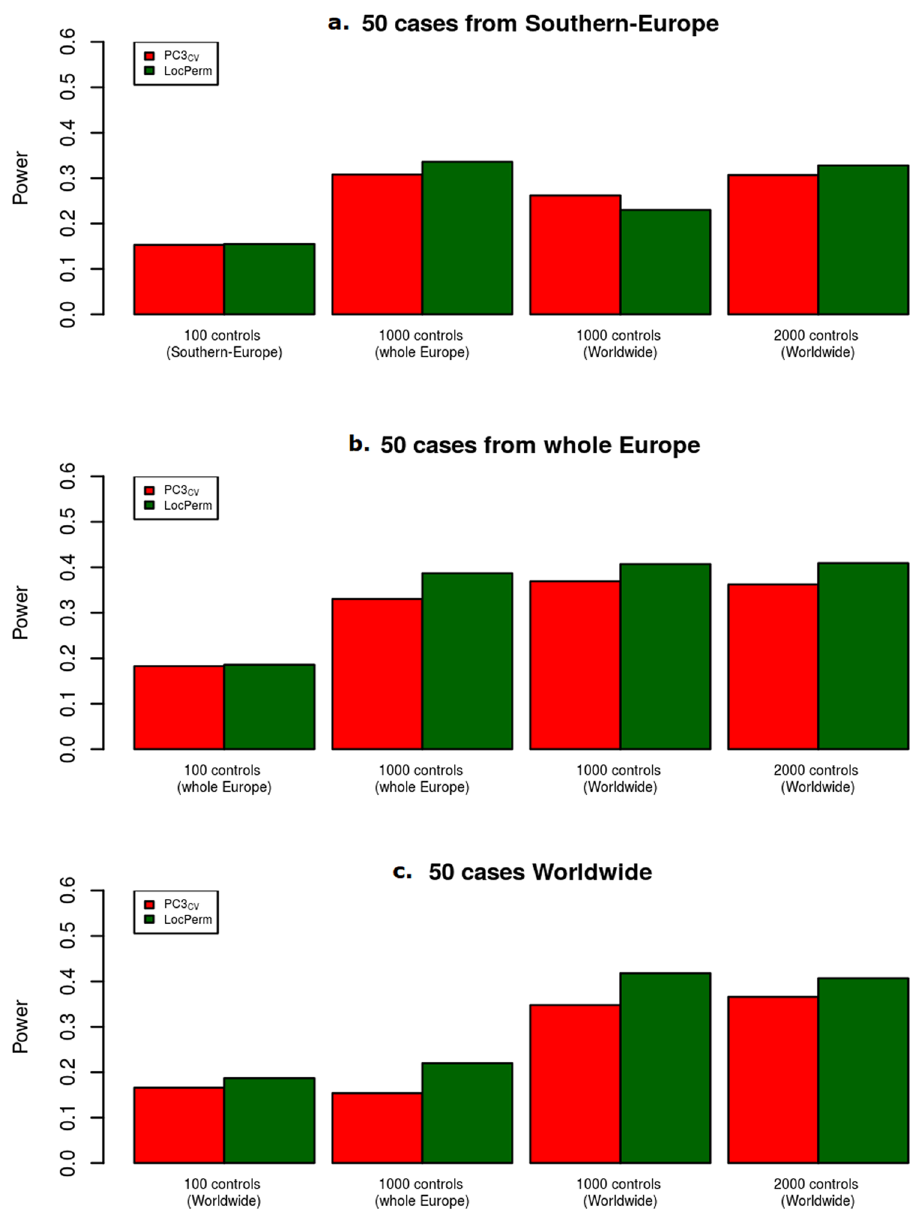
Europe. ( c ) Scenarios with 50 cases from the Worldwide sample. The relative risk is fixed at